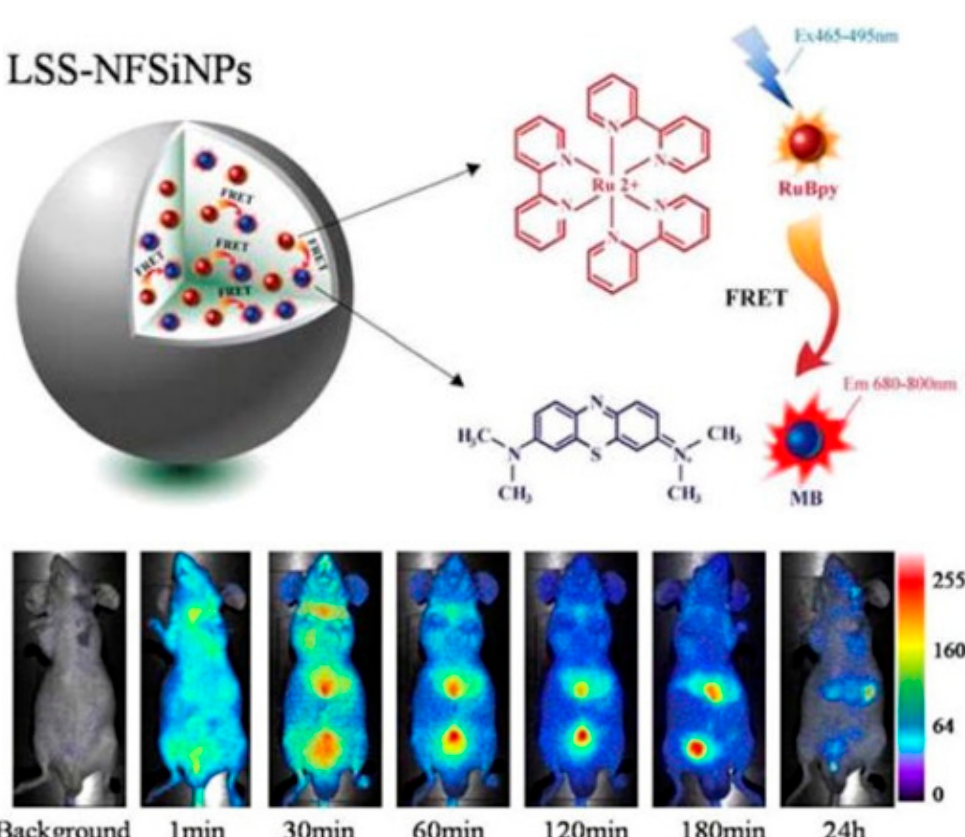
Figure 5. Experimental design for the large stokes shifting NIR fluorescent SiNPs (LSS-NFSiNPs) and real-time abdomen fluorescence resonance energy transfer (FRET) imaging of mice intravenously injected with the LSS-NFSiNPs. Reproduced with permission from [30]. Copyright 2012 American Chemical Society.